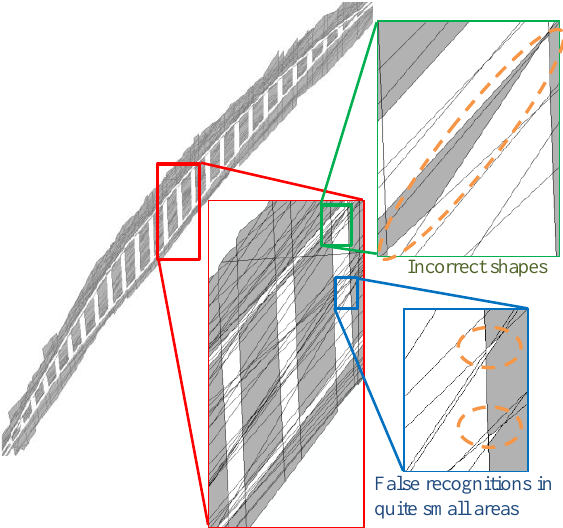
Figure 14. Result of traffic marking extraction with wide area processing